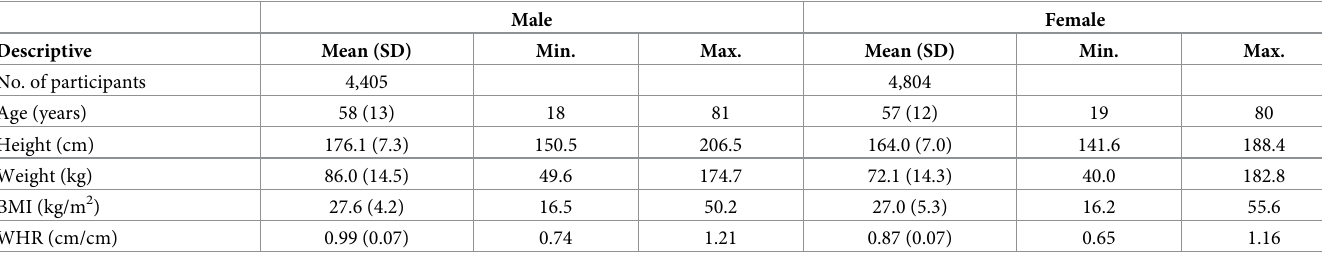
Table 1. Summary characteristics of LIFE-Adult participants considered in the present